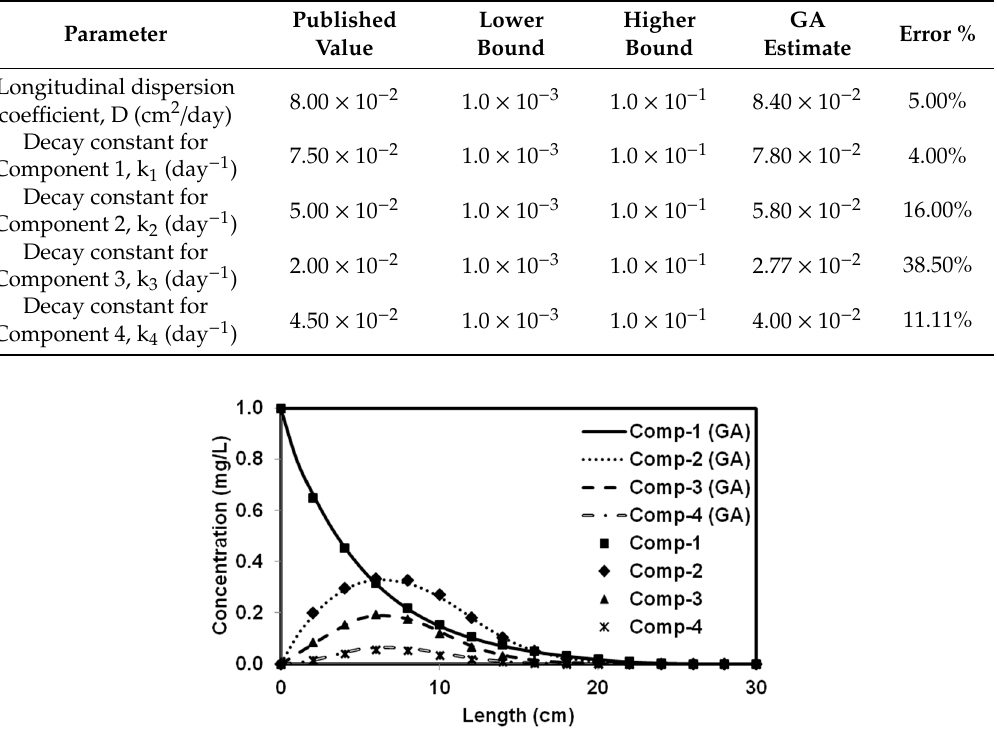
Table 3. Comparison of the PGA-estimated parameters with true solutions along with their bounds for benchmark problem 2.